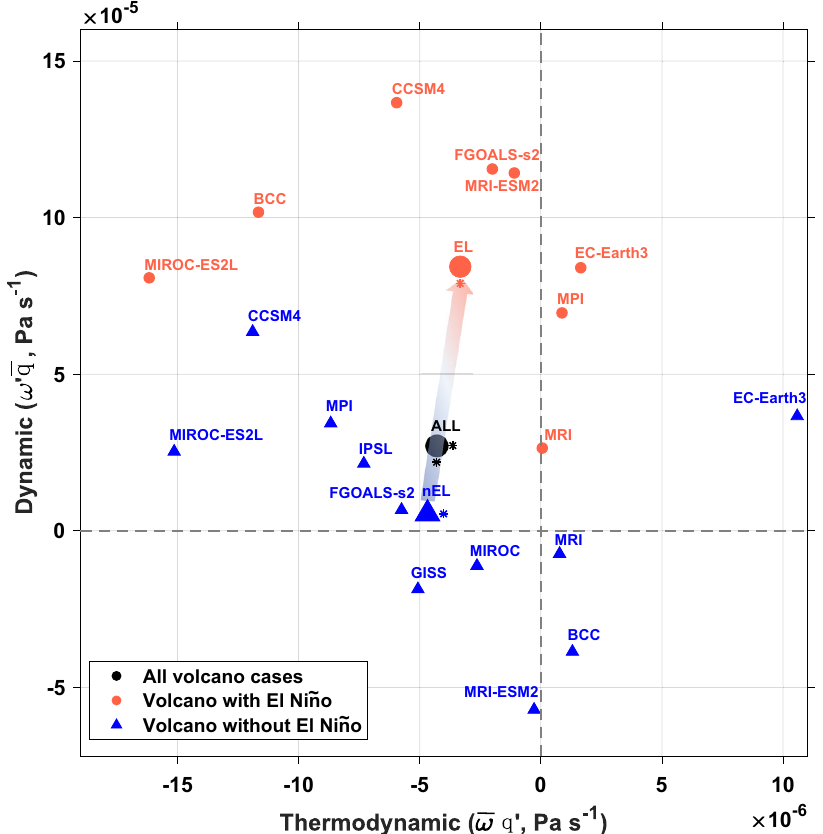
Fig. 4 Simulated dynamic and thermodynamic responses of EASM to tropical eruptions modulated by El Niño. Plotted are the composite dynamic part ( ω 0 (cid:1) q ) versus thermodynamic part ( (cid:1) ω q 0 ) of post-eruption EASM precipitation changes after all 78 eruptions in 11 PMIP last millennium simulations from 1470 to 1849 AD (All, dark dot), as well as those of the 21 eruptions with (EL, orange dot) and 57 eruptions without (nEL, blue triangle) El Niño responses in the fi rst boreal winter after eruptions. CSIRO and HadCM last millennium simulations are not included due to the lack of vertical velocity. Asterisks to the right and bottom of the symbols denote the thermodynamic and dynamic anomalies signi fi cant at the 90% con fi dence level, respectively. The arrow indicates a change from the ensemble mean for eruptions without El Niño responses to those with El Niño responses. Results for each model are also shown by the small dots and triangles. Signi fi cant tests have not been performed for single models due to the small sample size of El Niño events. This fi gure was created using MATLAB 2020a